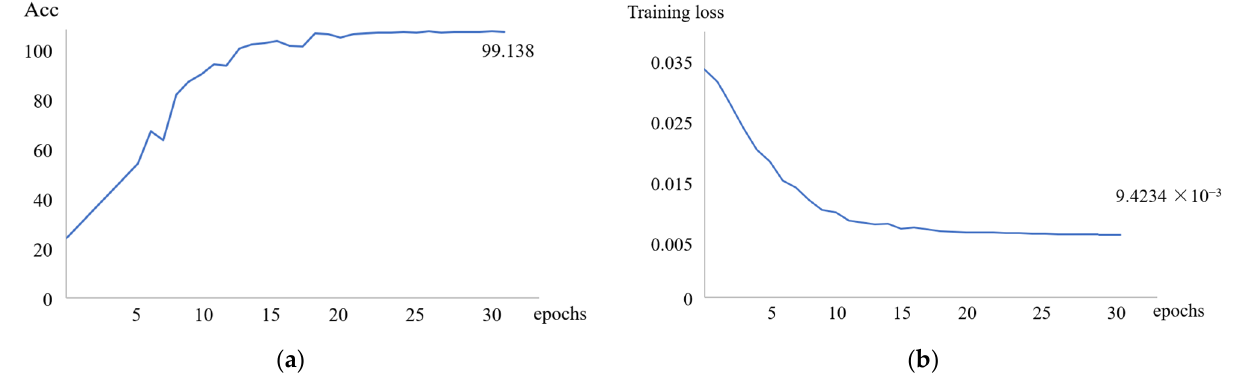
Figure 10. ( a ) The accuracy of ED Net; ( b ) the training loss of ED Net.